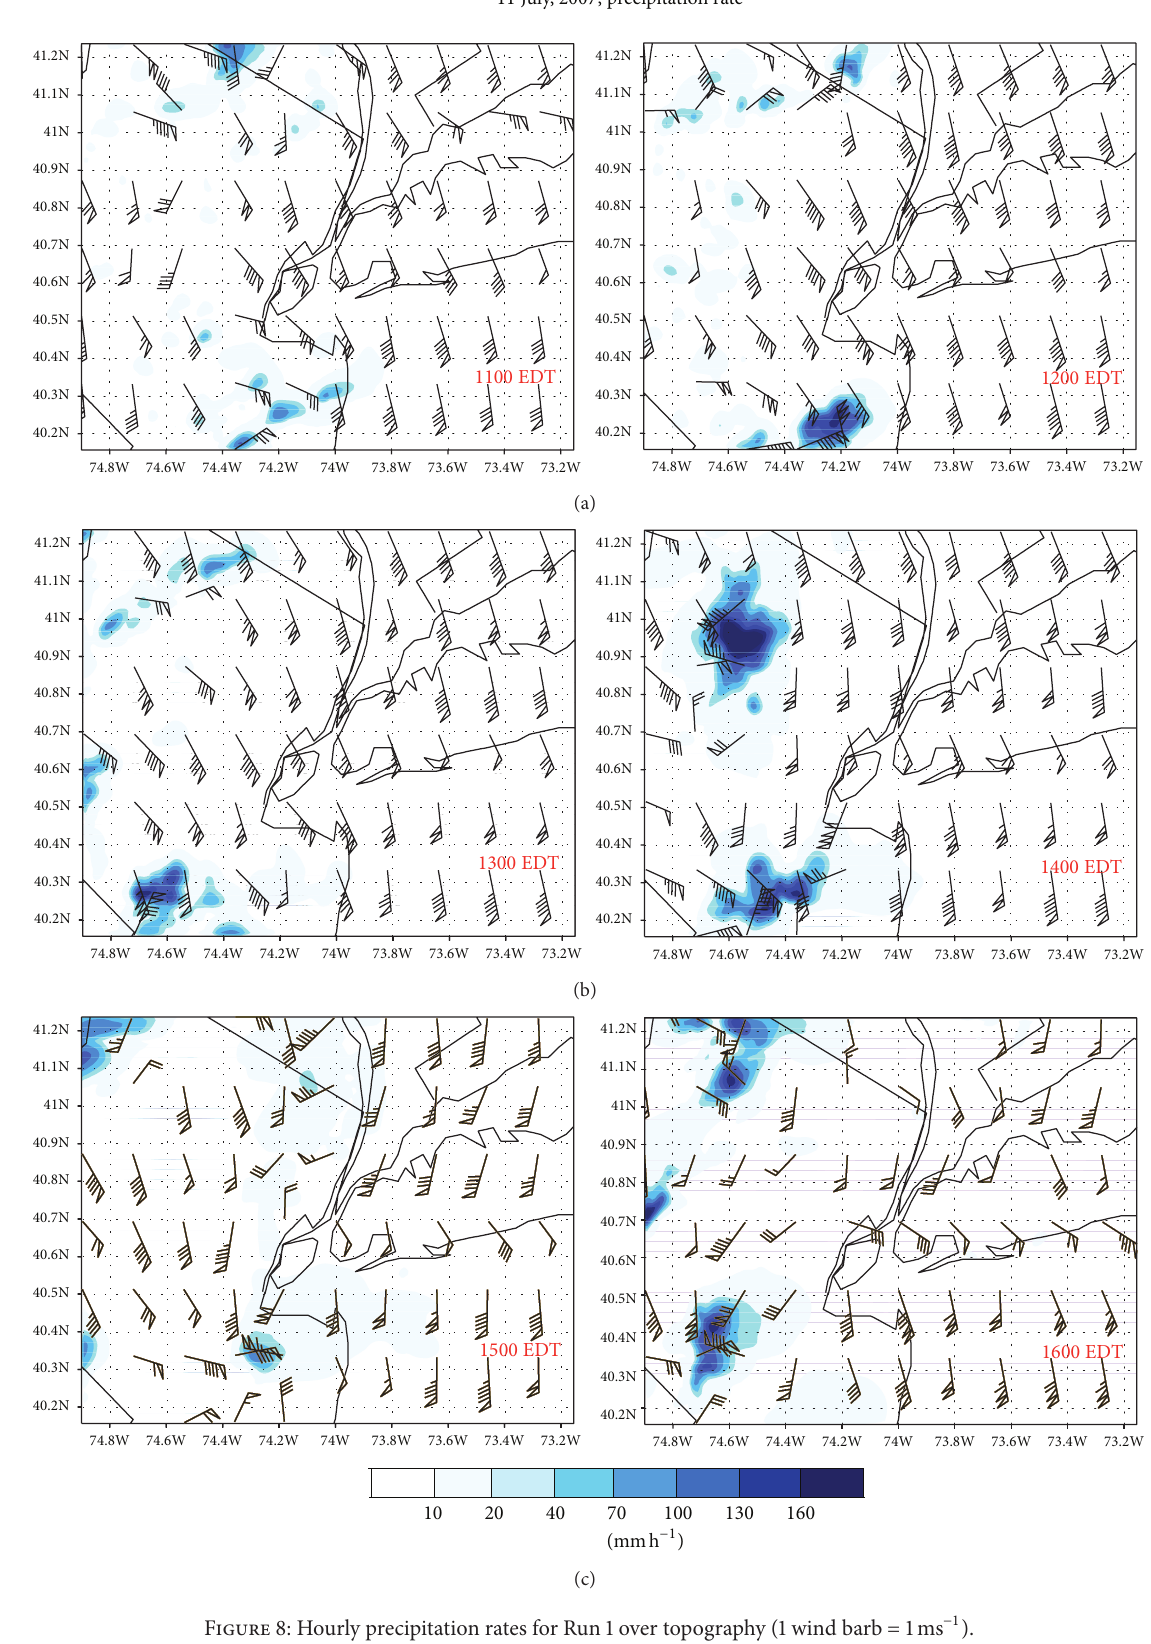
Figure 8: Hourly precipitation rates for Run 1 over topography (1 wind barb = 1 ms −1